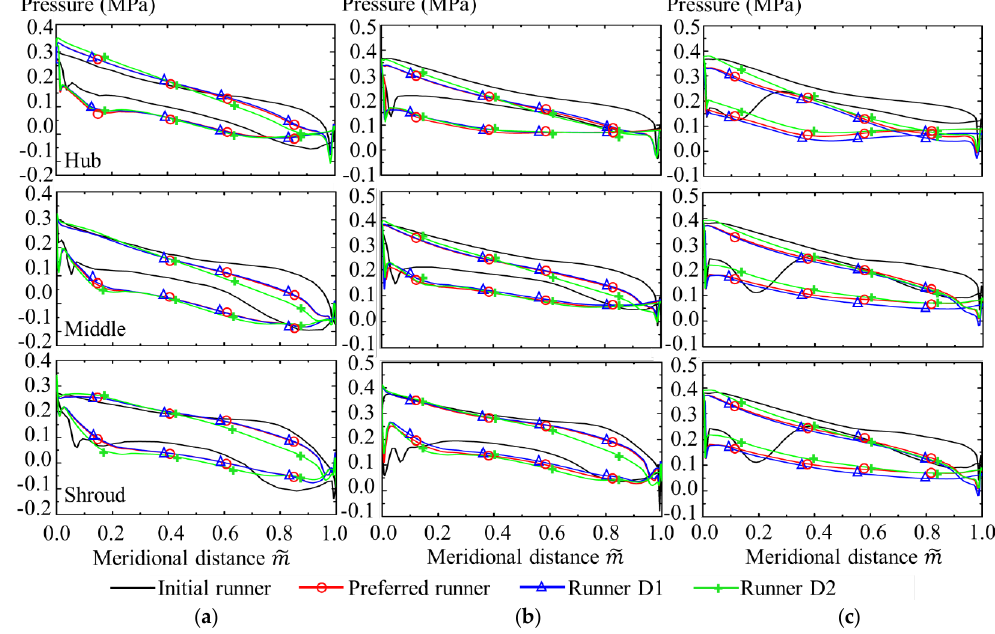
Figure 12. Pressure distribution on different spanwise for the initial and optimized runners under rated head. ( a ) Hub; ( b ) Middle span; ( c ) Shroud.